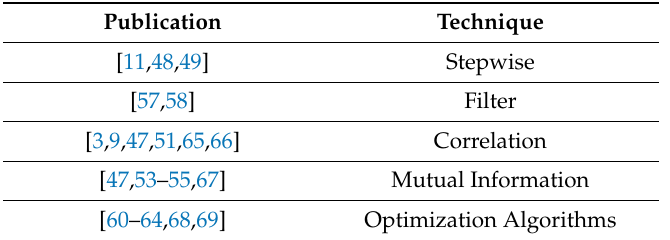
Table 3. List of publications employing different feature selection